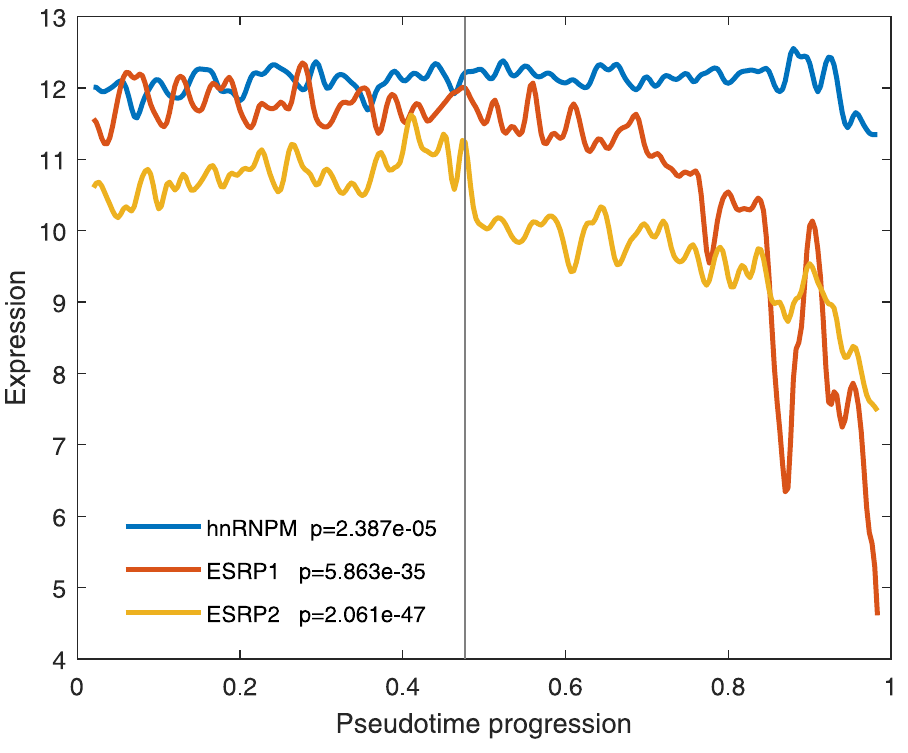
Fig 9. Reconstructed expression dynamics of hnRNPM, ESRP1 and